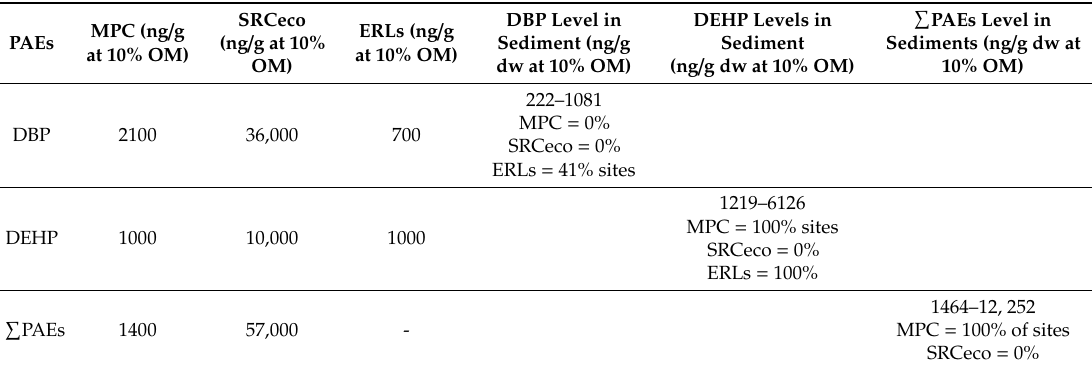
Table 6. Equilibrium partition (EqP) values of DEHP and DBP in U-Tapao